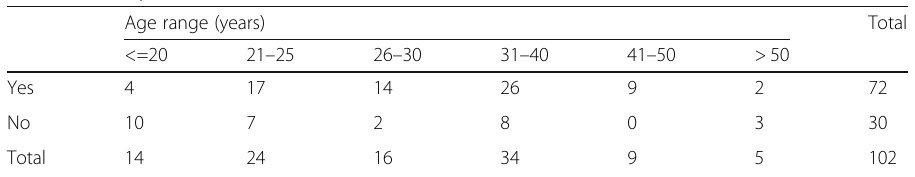
Table 4 Have you ever taken an online course before? Age range